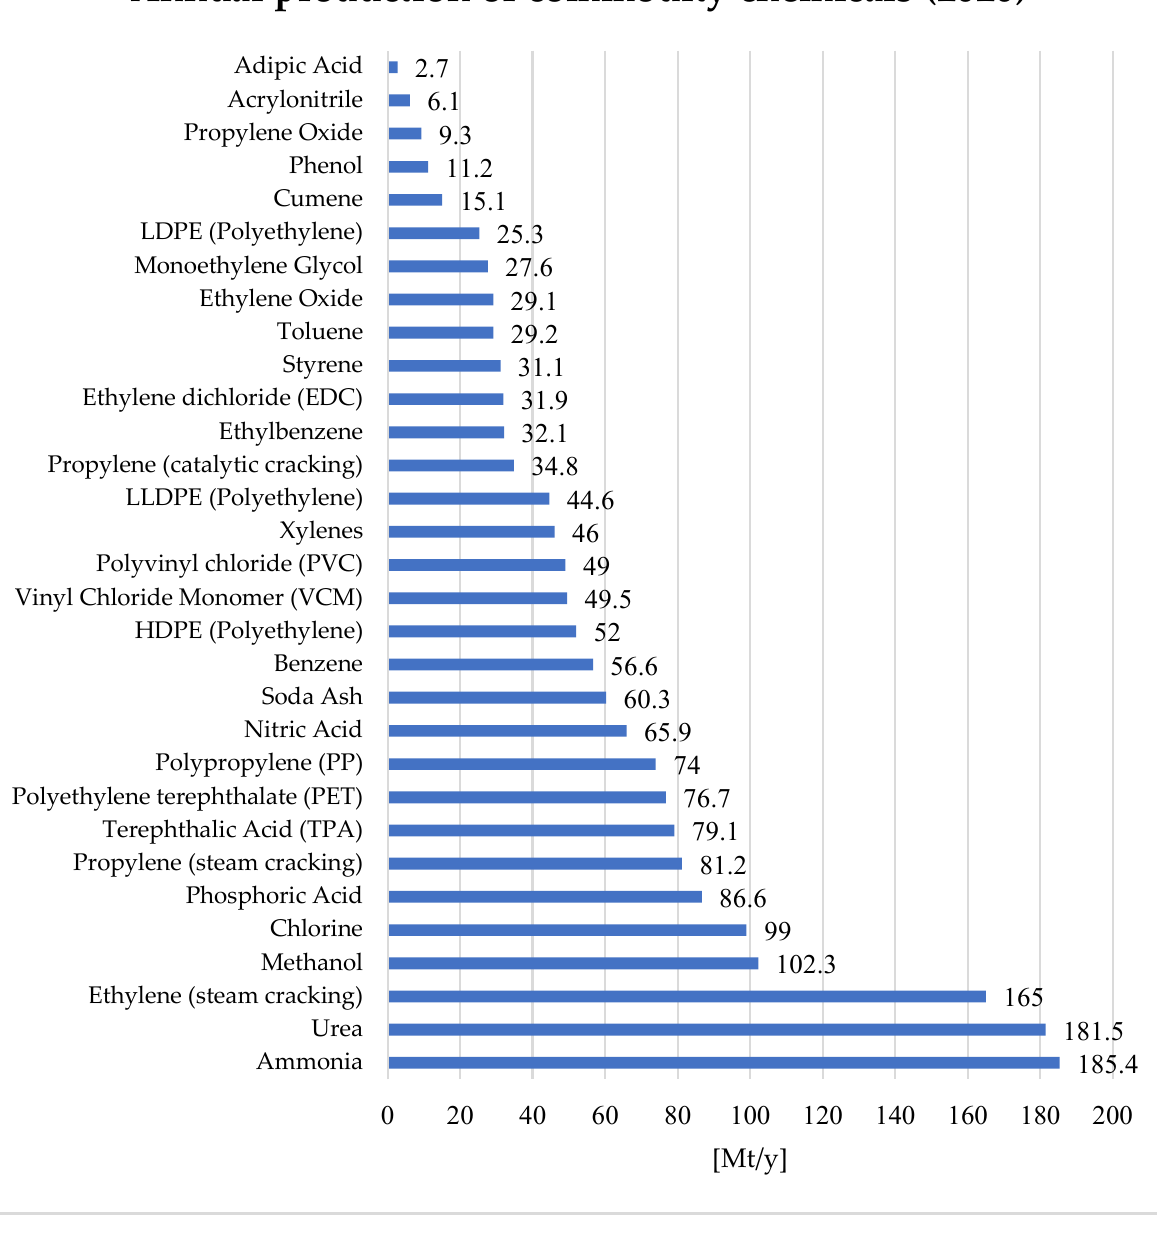
Figure 2. Annual production of commodity chemicals (2020). Note that 4165.1 Mt/y of oil (including crude oil, shale oil, oil sands, condensates, and natural gas liquids) were processed in the same year [13]. Data from [15–45].